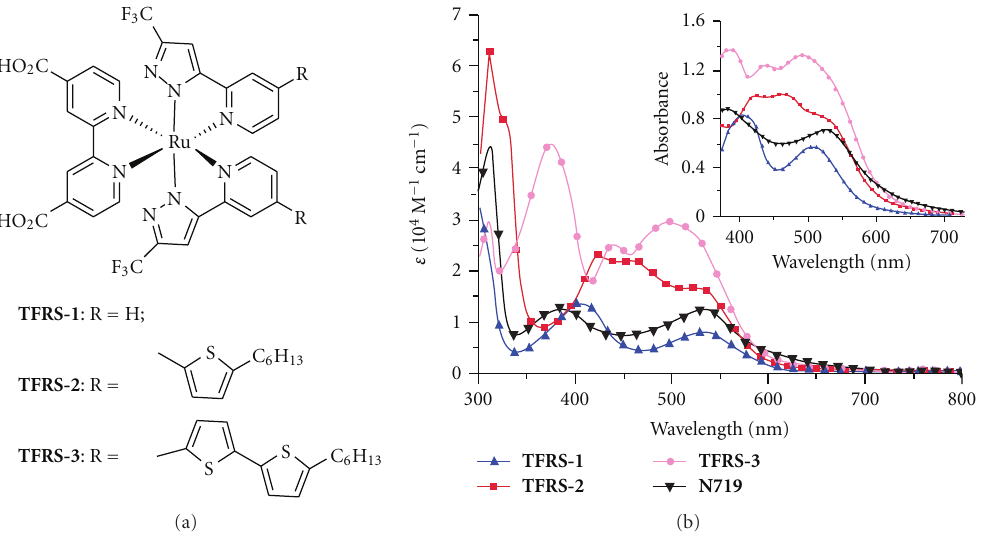
Figure 37: Molecular structures of Ru(II) sensitizers TFRS-1–3 and absorption spectra of TFRS , N719 in DMF (taken from [61]).